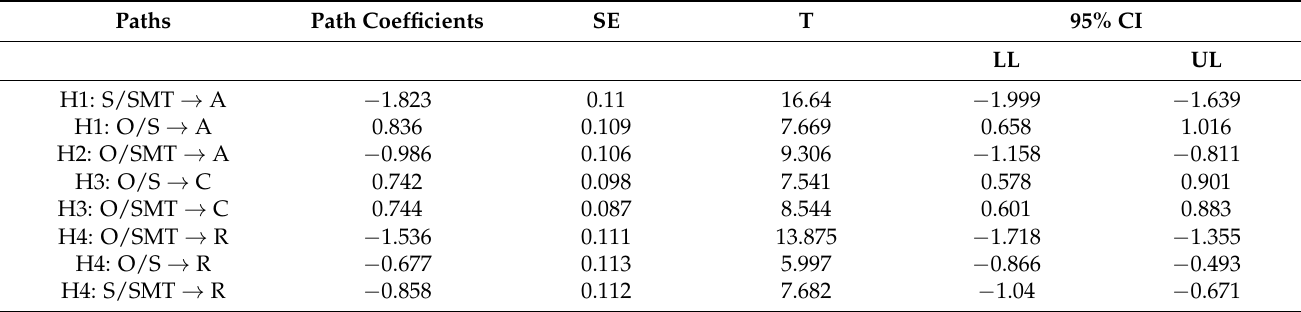
Table 2. Structural Model. Direct Relationships Testing